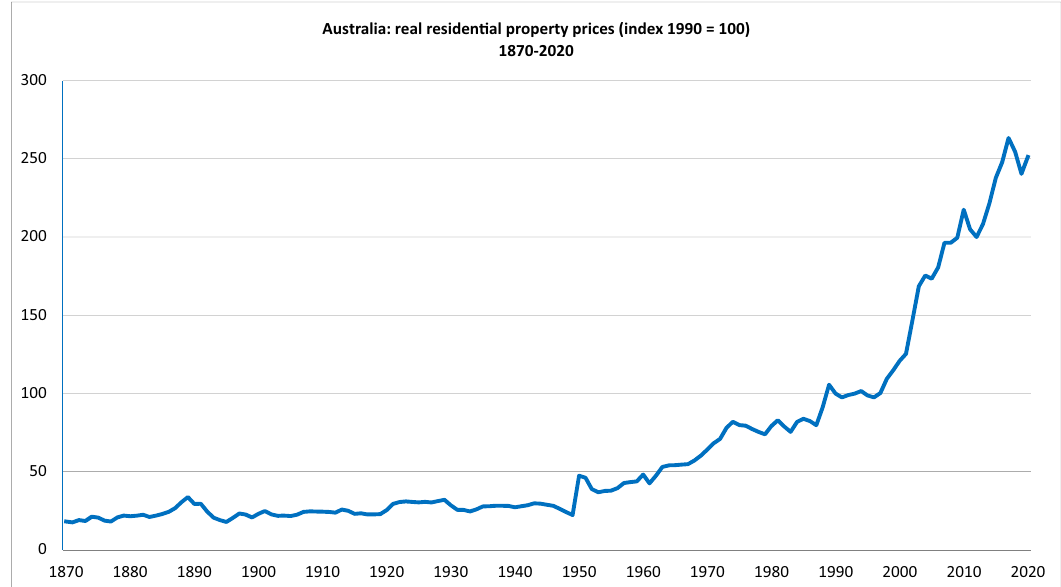
Figure 2: Australia: real residential property prices ( index 1990 = 100 ) 1870 –